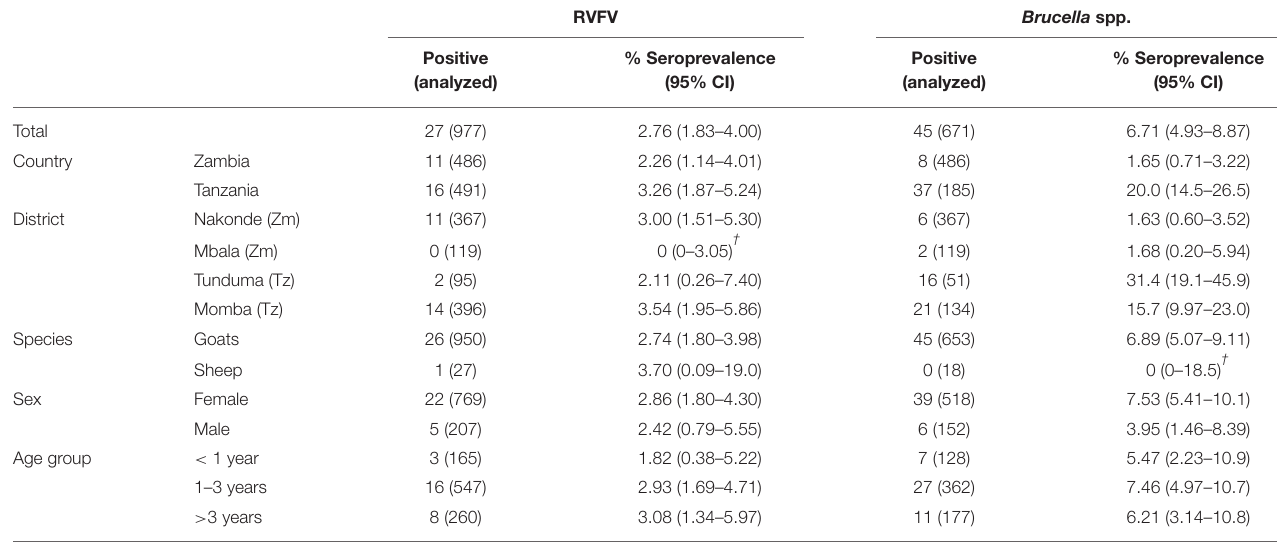
TABLE 4 | Apparent animal-level seroprevalence for RVFV and Brucella